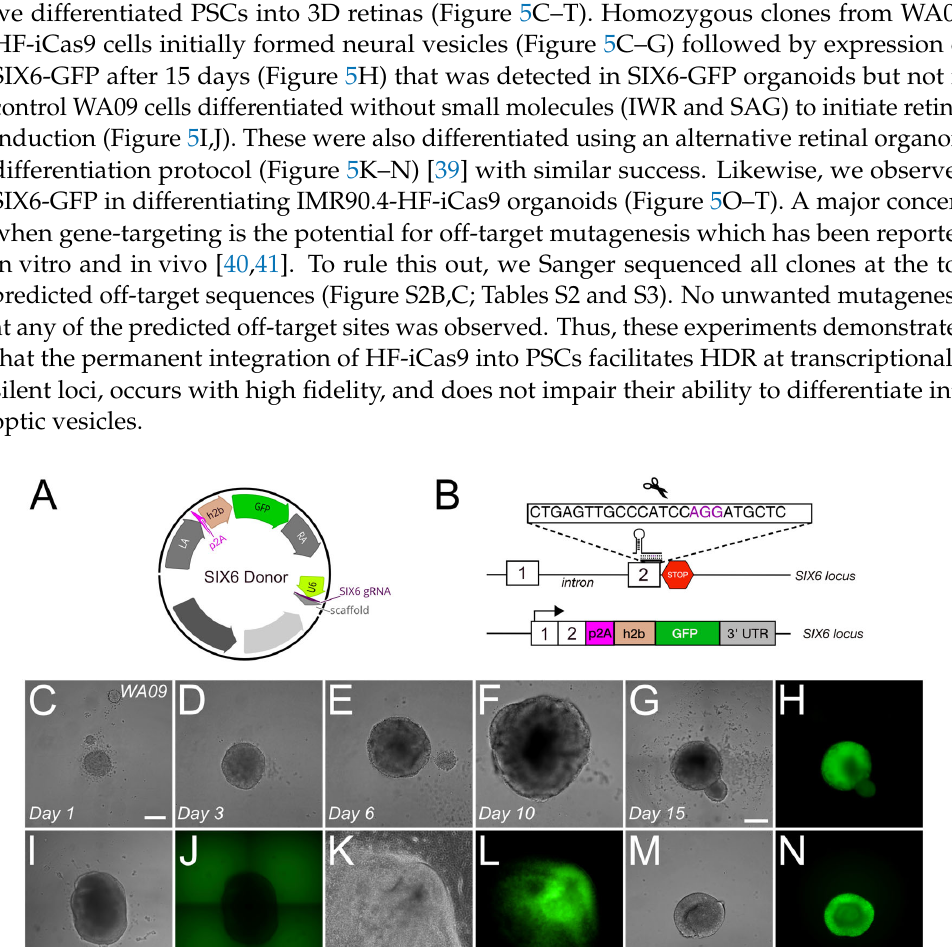
( G – J ) = 400 µ m; ( K – L , Q – R ) = 150 µ